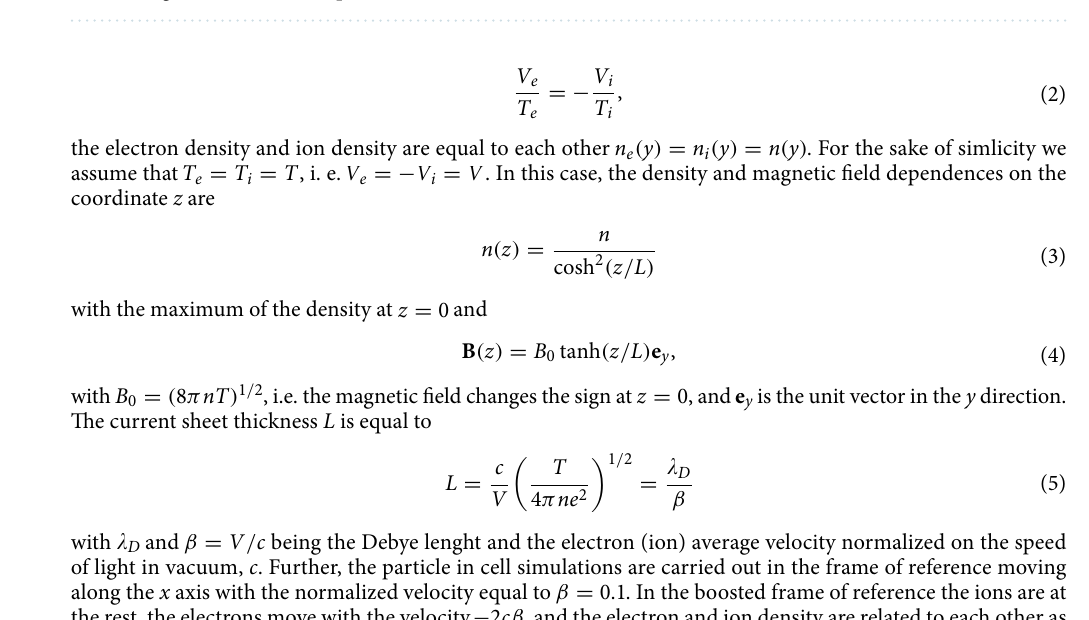
Figure 1. ( a ) Schematic of plasma system sustained by electron current sheet. Magnetic reconnection is induced along with the plasma filamentation. The initial conditions of ( b ) the electron number density n e and ( c ) the magnetic field are also